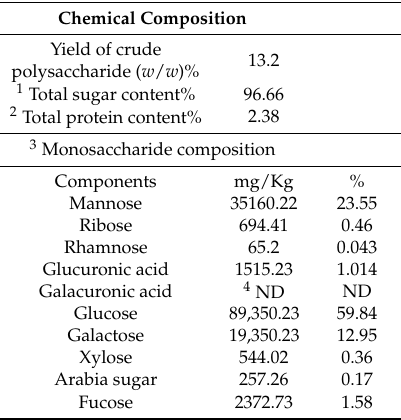
1 Phenol-H 2 Bicinchoninic acid method; 3 High performance liquid chromatography (HPLC); 4 ND, 2 SO 4 method; not detected.